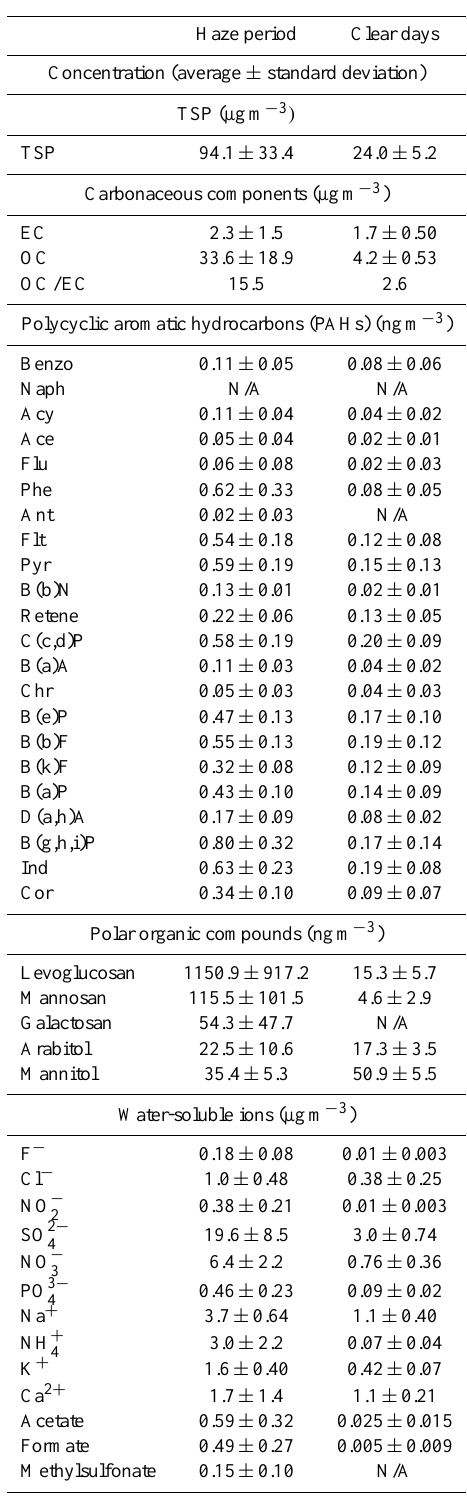
Table 1. Mass concentrations of TSP and associated chemical com- ponents during haze and clear periods at St. John’s Island in Singa-